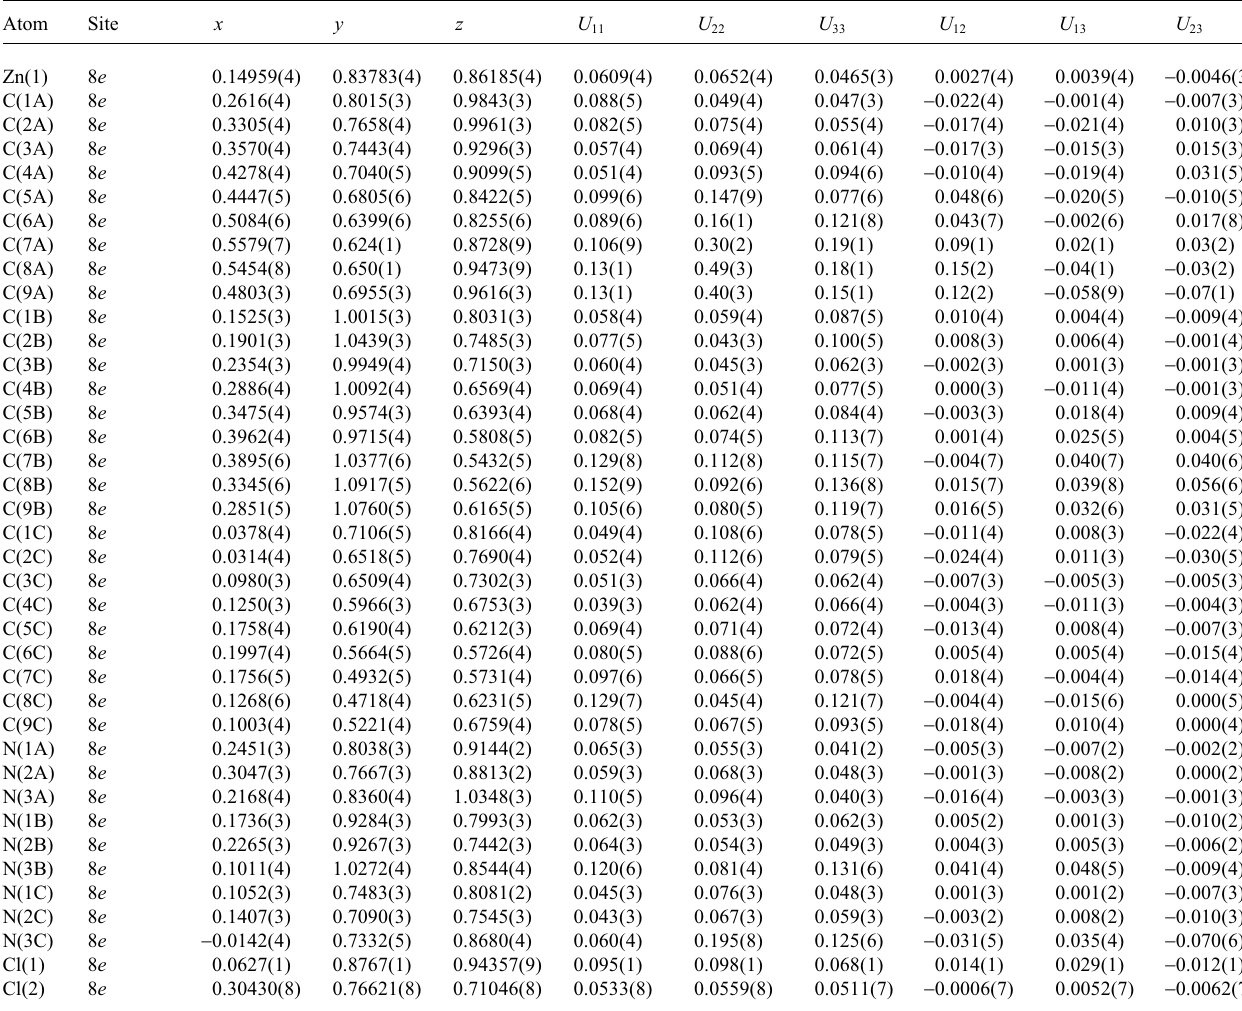
Table 3. Atomic coordinates and displacement parameters (in Å 2 ) .